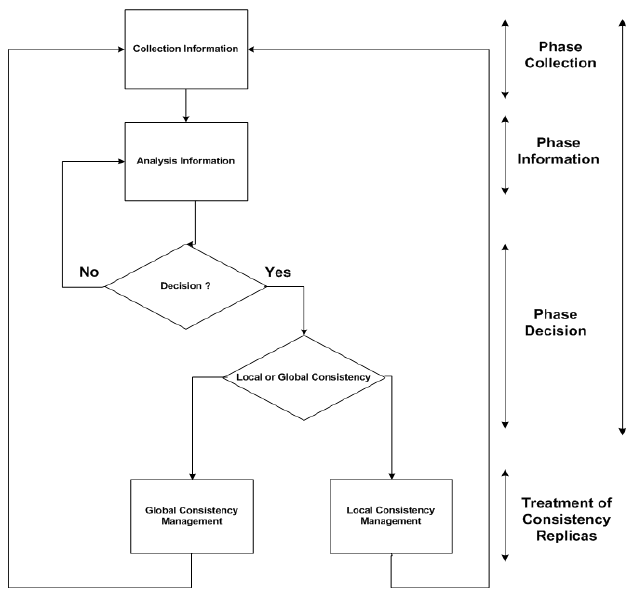
Figure 2. Functional view of RCCR